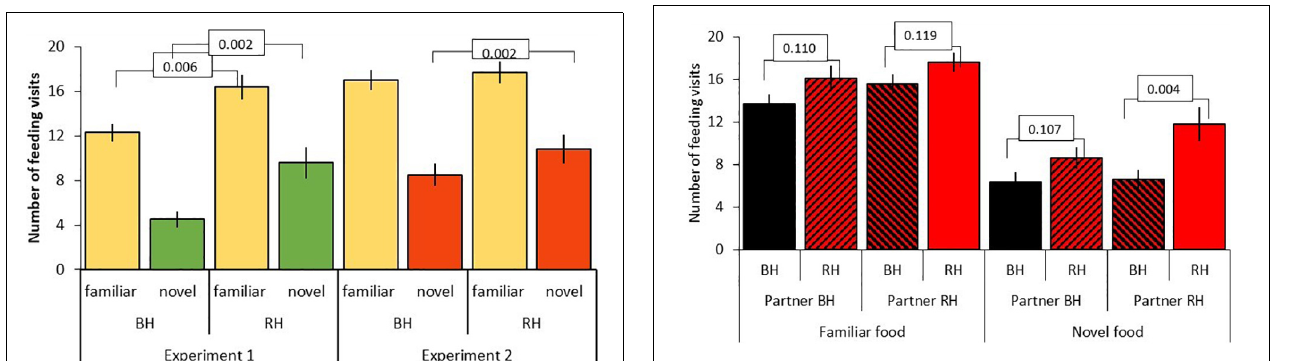
FIGURE 5 | Number of feeding visits after first feed (mean ± SE) to familiar (beige) and novel food (green, red) in experiment 1 and 2 for red-headed (RH) and black-headed (BH) Gouldian finches. Numbers in the figure represent p -values.